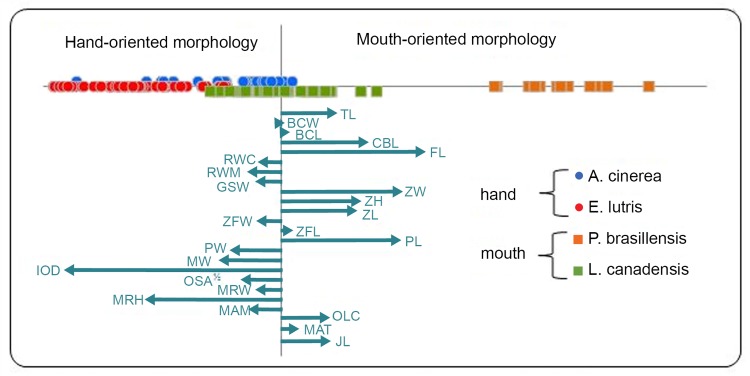
Multivariate regression ordination of skull shape based on feeding mode.Symbols reflect feeding mode for each species (circles, hand-oriented; squares, mouth-oriented). Ellipses depict standard errors for regression scores. Vectors give partial regression coefficients (trait abbreviations as in Table 1). Individuals (data points color-coded by species) and species to the right in this space have elongate skulls, especially for relative palate and jaw length, and have narrow palate width, small intra-ocular distance and shallow mandibular rami.